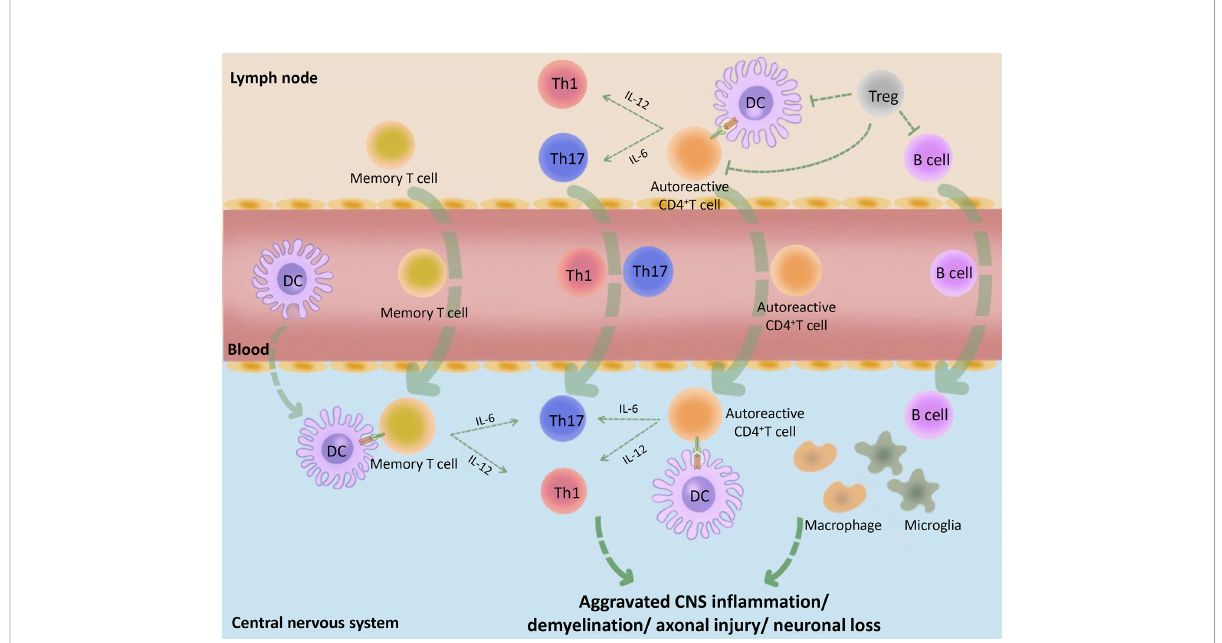
FIGURE 1 Basic immunopathological process of MS. Initially, the peripheral tolerance of MS patients is disordered (for example, the inhibitory function of Tregs is decreased or the Teffs are not sensitive to the inhibitory effect of Tregs) and the autoantigens, such as MBP, MOG and PLP,